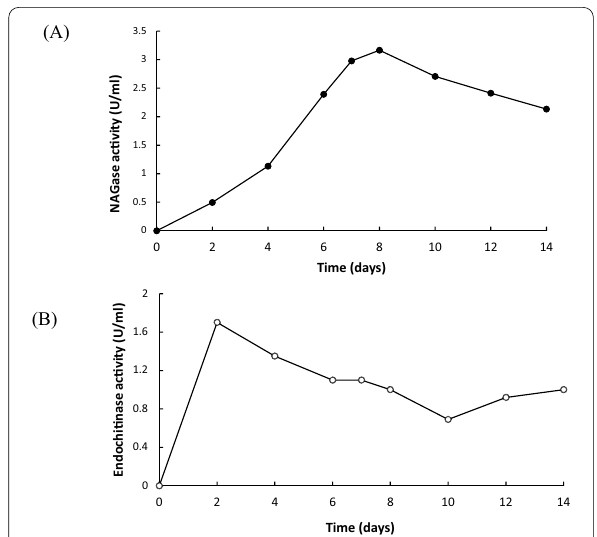
Fig. 1 Induced production of endochitinase and NAGase. T. virens strain mango was cultured in a colloid chitin‑containing liquid medium followed by the determination of A NAGase and B endochitinase